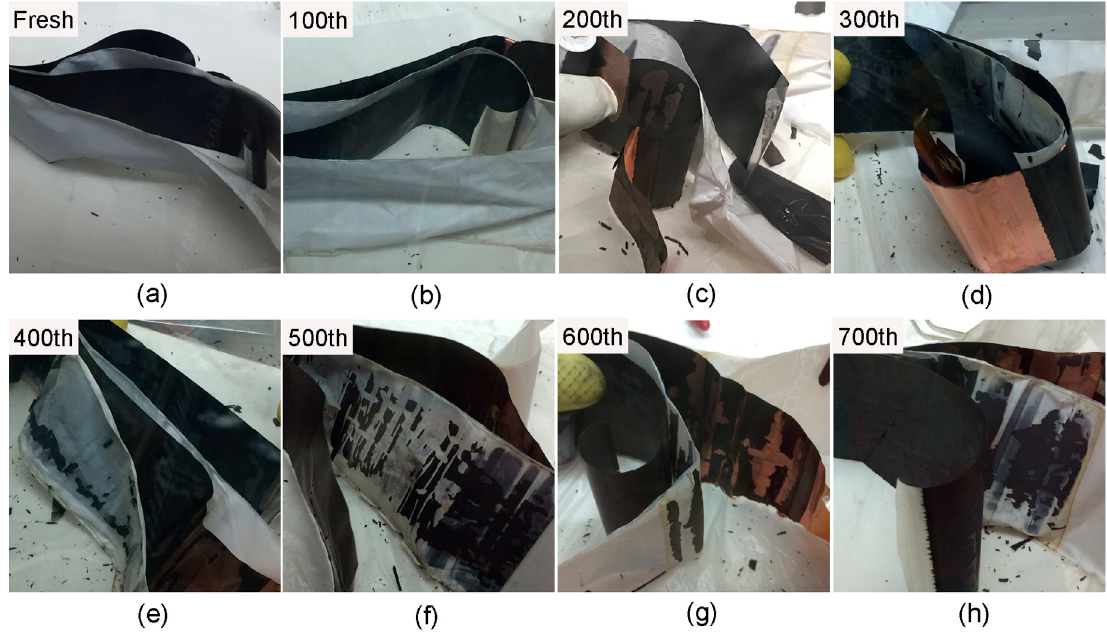
Figure 5. Pictures of harvested cell parts including LCO + NMC532 cathodes, Gr electrodes and separators experienced various cycles: ( a ) fresh; ( b ) 100th; ( c ) 200th; ( d ) 300th; ( e ) 400th; ( f ) 500th; ( g ) 600th; ( h ) 700th.